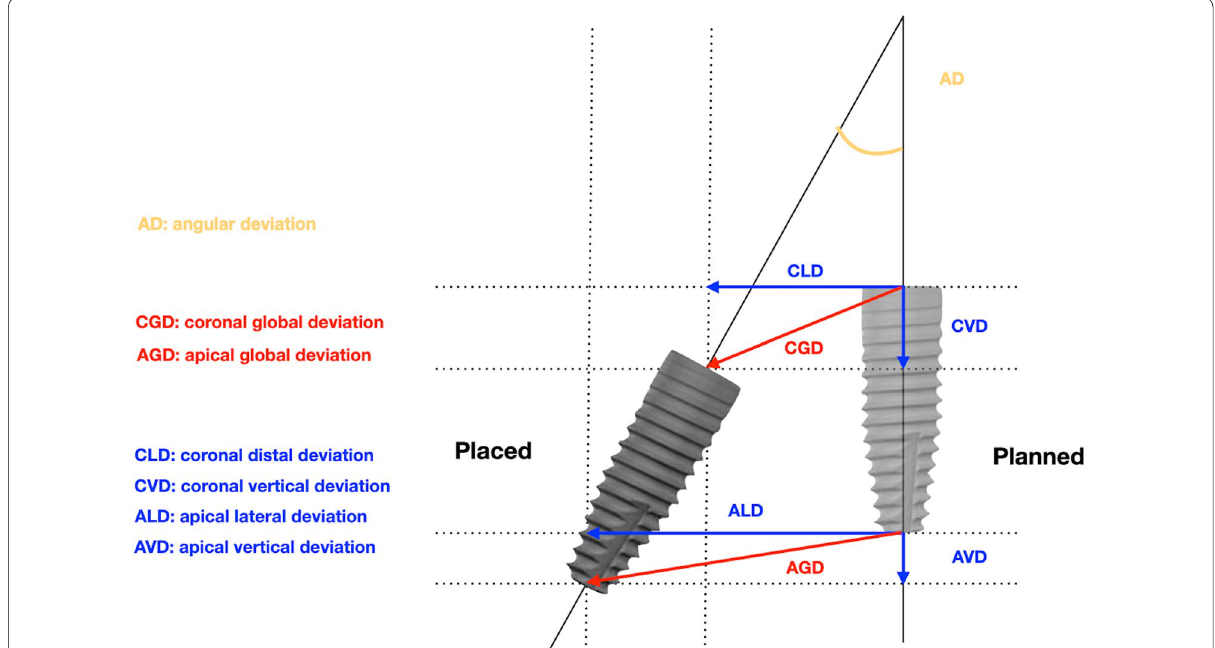
Fig. 4 Parameters of deviation between the planned implant (right) and actual implant (left) position. AD angular deviation, CGD coronal global deviation, GAD global apical deviation, CDD coronal distal deviation, ADD apical distal deviation, CAD coronal apical deviation, AAD apical apical deviation, CVD coronal vestibular deviation, AVD apical vestibular